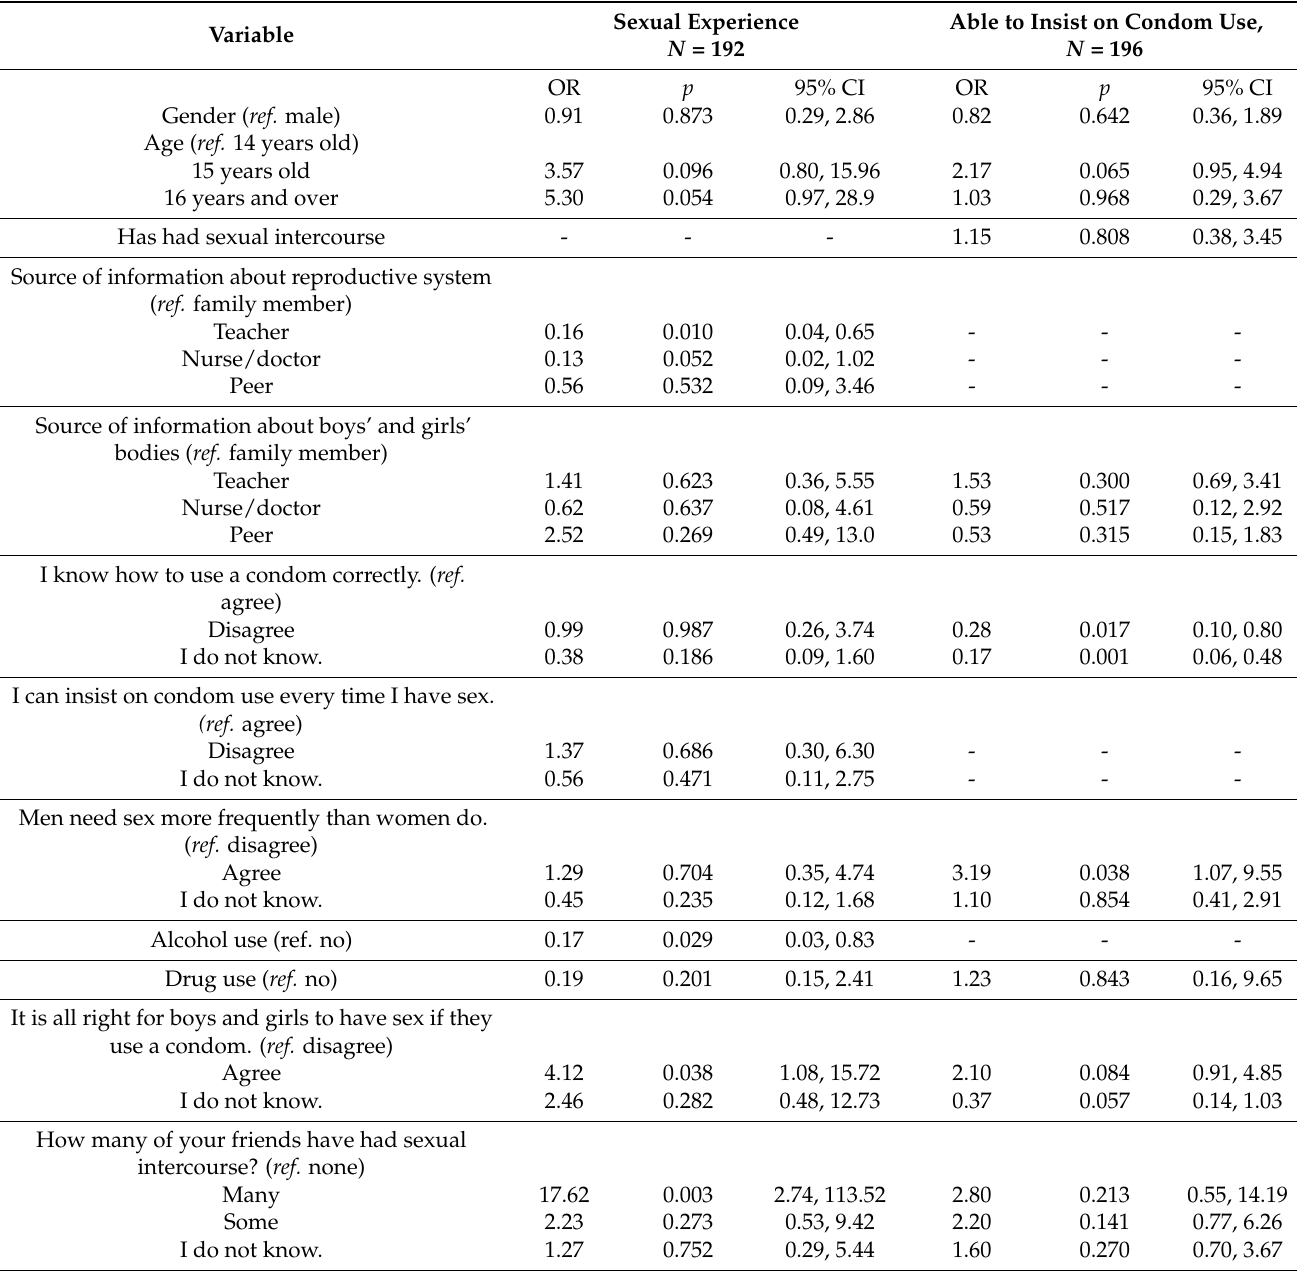
Sexual Experience Able to Insist on Condom Use, N = 192 N = 196 OR p 95% CI OR p 95% CI